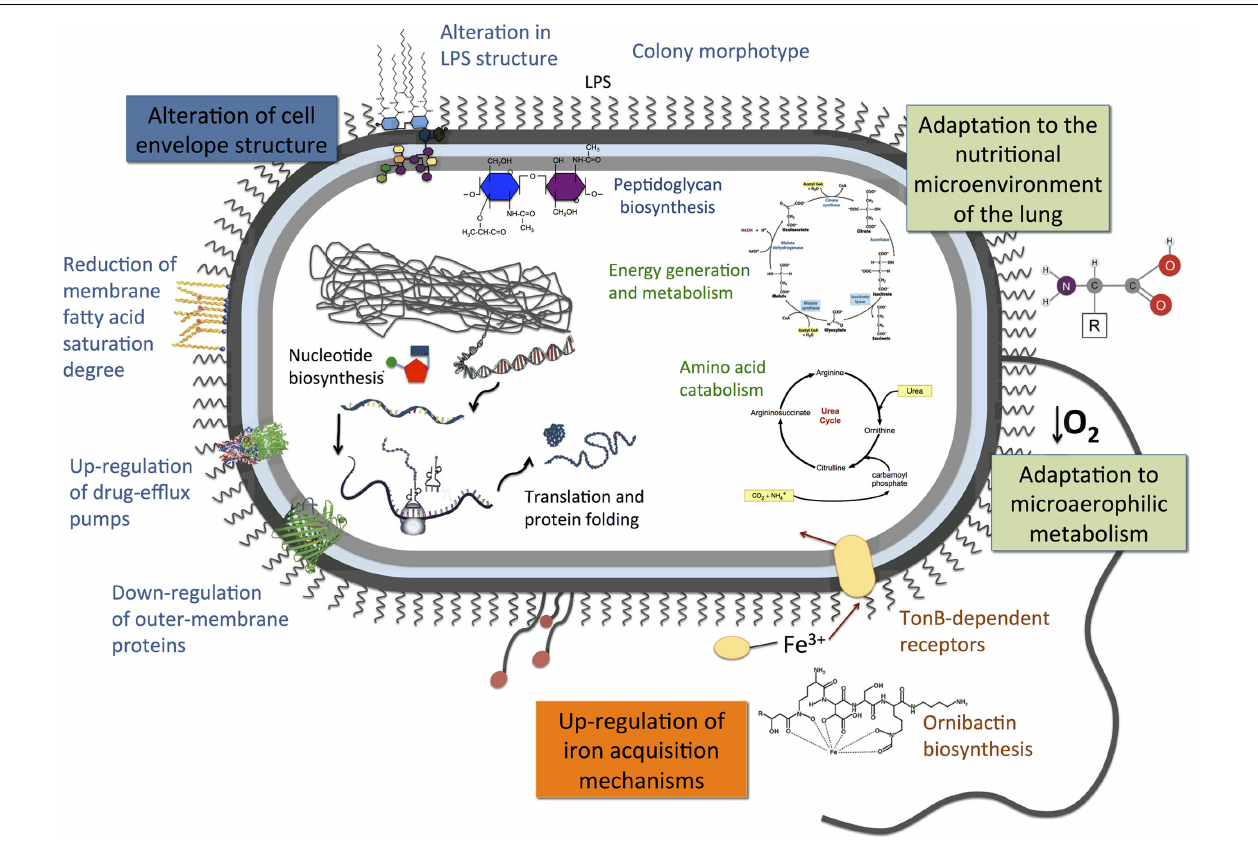
model is based on the results obtained from the comparison of transcriptomic, proteomic, and phenotypic profiling of sequential clinical isolates collected from the same chronically colonized CF